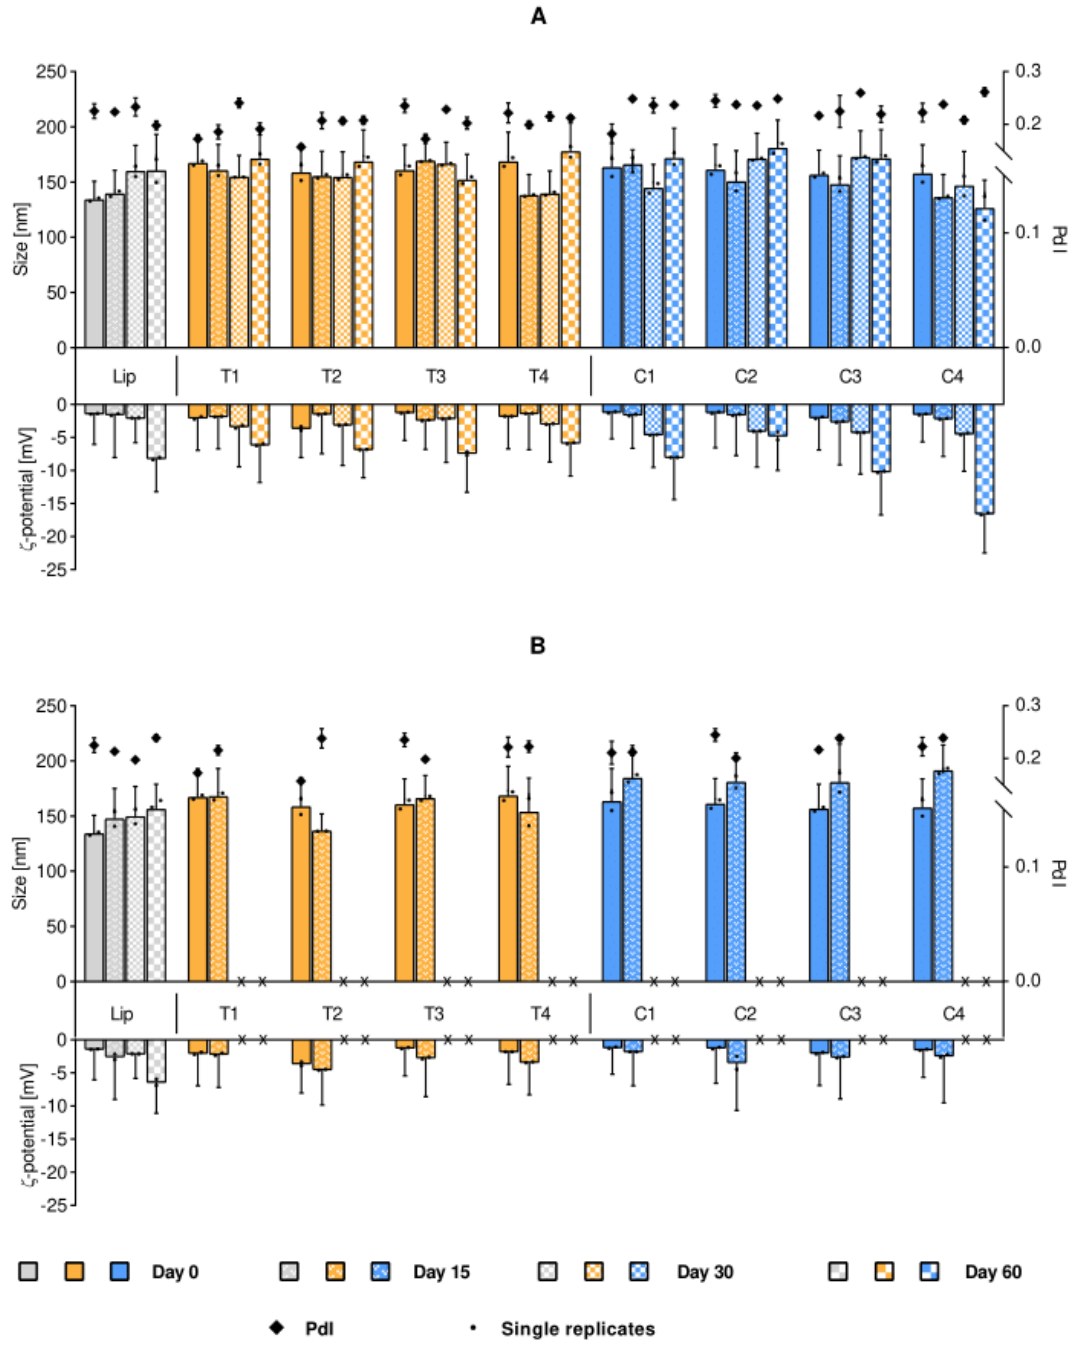
Figure 2. Stability of liposomal suspensions upon storage at 4 ◦ C (panel A ) and 25 ◦ C (panel B ). The stability is expressed as changes in original liposomal size and ζ -potential. Each bar cluster represents a suspension over time (Day 0, 15, 30 and 60, when measurable). The size is presented on the positive y-axis, where the bars refer to the main peak (primary y-axis), together with the associated SD (half width of the peaks) and the mean of the single replicates (small dots, n = 2). The diamonds correspond to the PdI (secondary y-axis) mean, with associated SD. The ζ -potential stability is displayed on the negative y-axis, with corresponding SD and single replicates. Isotonic phosphate bu ff er was used in pre-dilutions for size measurements, while distilled water was used for the ζ -potential determination. Abbreviations: Lip refers to empty liposomes (gray); T (yellow) and C (blue) refer to the lipid dye and the surface lipid dye, respectively; PdI is the polydispersity index; SD is the standard deviation.